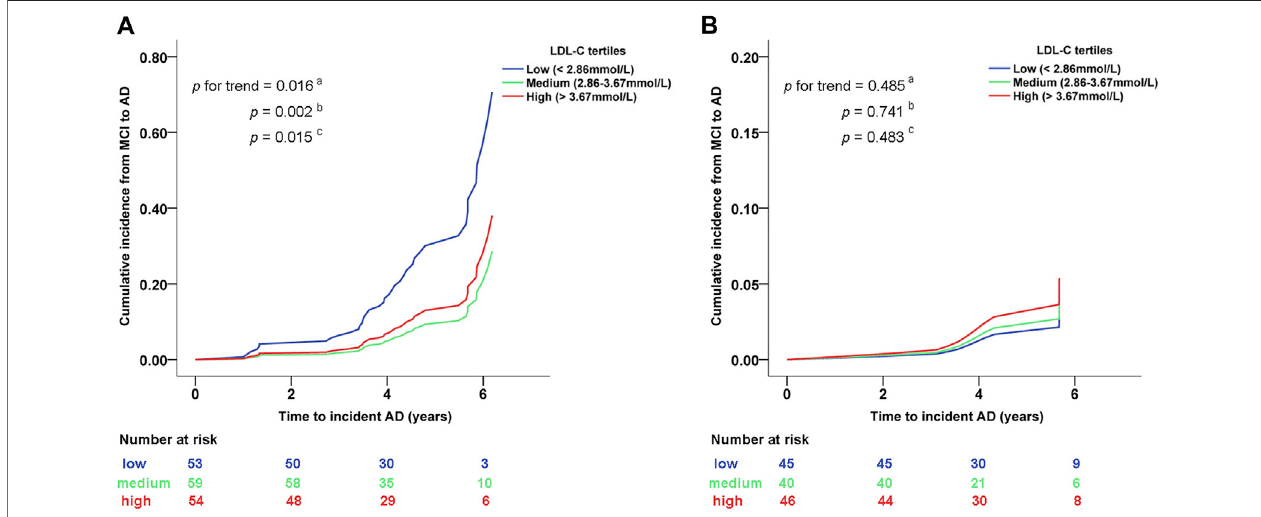
FIGURE 3 | Cumulative conversion rate from MCI to AD between different LDL-C category levels in subgroups strati fi ed by PVRL2 rs6859 genotypes. (A) PVRL2 rs6859 AG/AA genotype subgroup. (B) PVRL2 rs6859 GG genotype subgroup. Cumulative incidence graphs are based on age, gender, APOE ε 4 status, education years, and lipid-lowering medication adjusted Cox models (from which indicated p values were extracted). a Trend p of cumulative incidence across the three groups of participants with different levels of LDL-C. b medium vs. low LDL-C. c high vs. low LDL-C. AD, Alzheimer ’ s disease; MCI, mild cognitive impairment; LDL-C, low- density lipoprotein